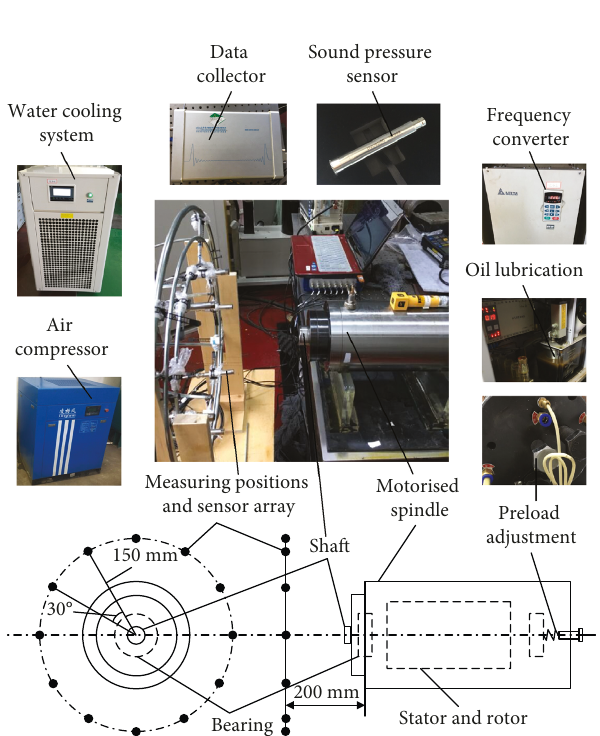
Figure 2: Experimental apparatuses and measurement